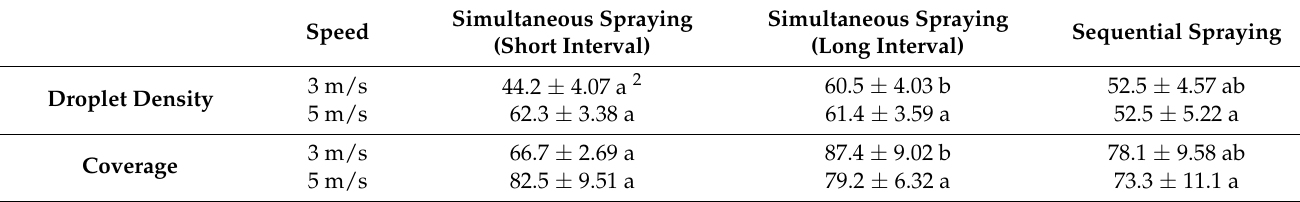
Table 4. Average CV value of droplet density and coverage in spraying